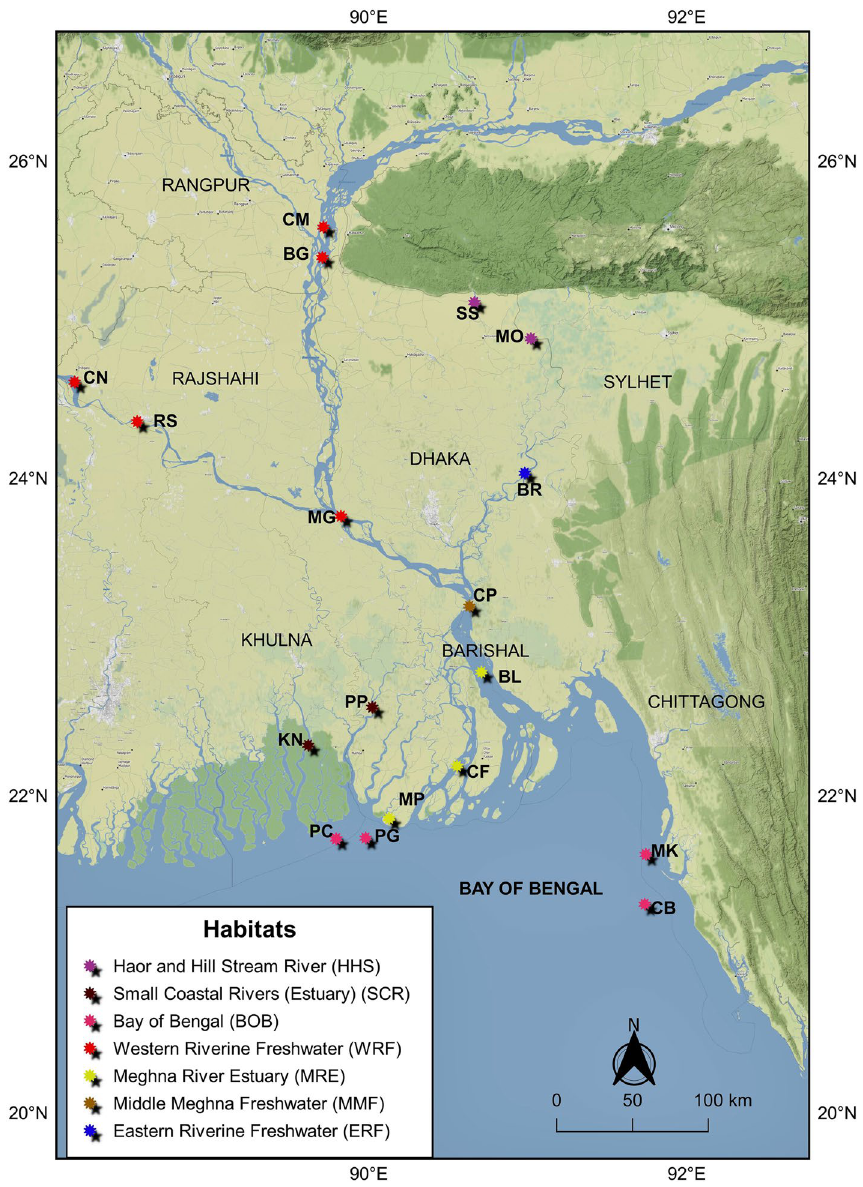
Figure 2. Map of sample collection sites of the highly migratory Hilsa shad across its diverse migratory habitats including all strategic aquatic ecosystems in Bangladesh. Each color indicates specific habitat group and abbreviated letter indicates sampling location. CM, Chilmari; BG, Balashi Ghat; CN, Chapai-Nababganj; RS, Rajshahi; MO, Mohanganj; SS, Someshwari river, Durgapur; MG, Manikganj; BR, Bhairab; CP, Chandpur ; KN, Khulna; PP, Pirojpur; BL, Bhola; MP, Mohipur; CF, Char Fasson; PC, Pokhkhir Char; PG, Patharghata; CB, Cox’s Bazar; MK, Maheshkhali. The map was produced by using QGIS version-3.4.1 with GRASS 7.4.2 (https:// qgis. org/ en/ docs/ index.